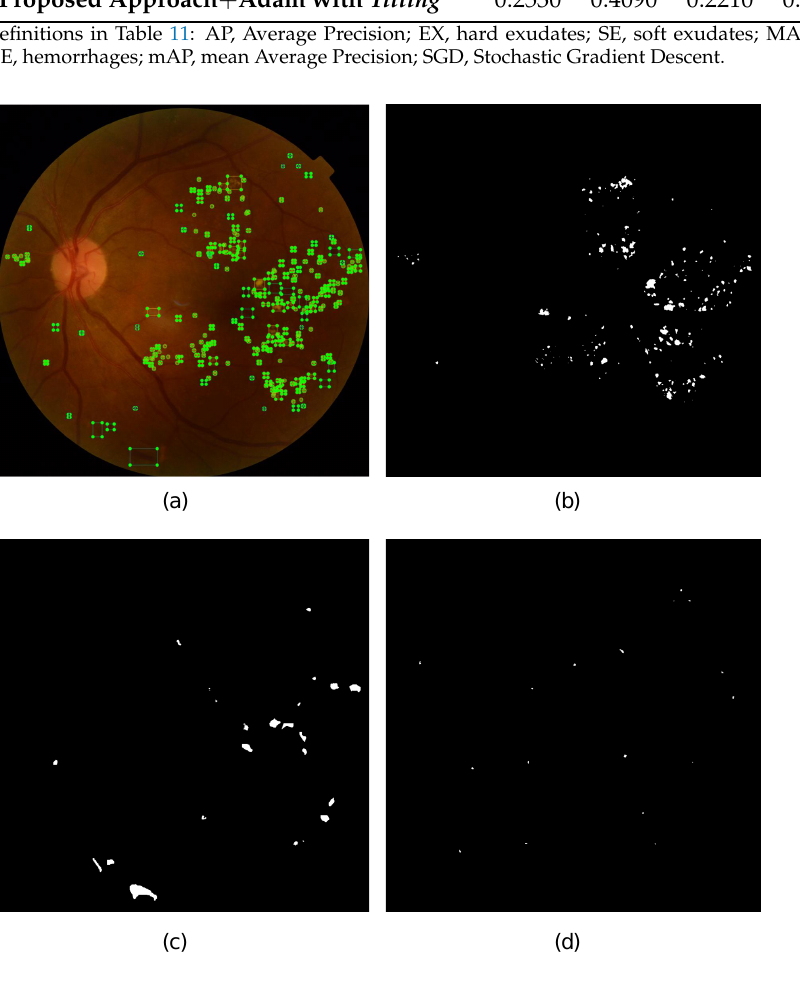
Figure 11. Example of fundus image of the dataset accompanied by the segmentation masks of the lesions present in the image. In ( a ), the fundus image “007-3711-200.jpg” of the test set from the Dataset for Diabetic Retinopathy (DDR), along with annotations ( Ground Truth ) of the fundus lesions; ( b ) segmentation mask of hard exudates; ( c ) hemorrhage segmentation mask; and ( d ) microaneurysm segmentation